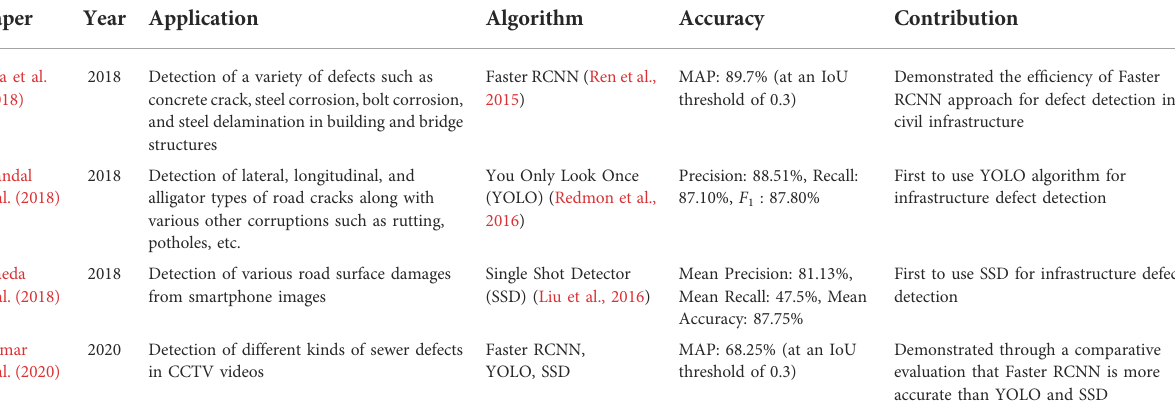
TABLE 2 Milestone papers focused on AI techniques for vision-based defect detection. MAP denotes the mean average precision. IoU represents the intersection over the union of the predicted and ground-truth defect